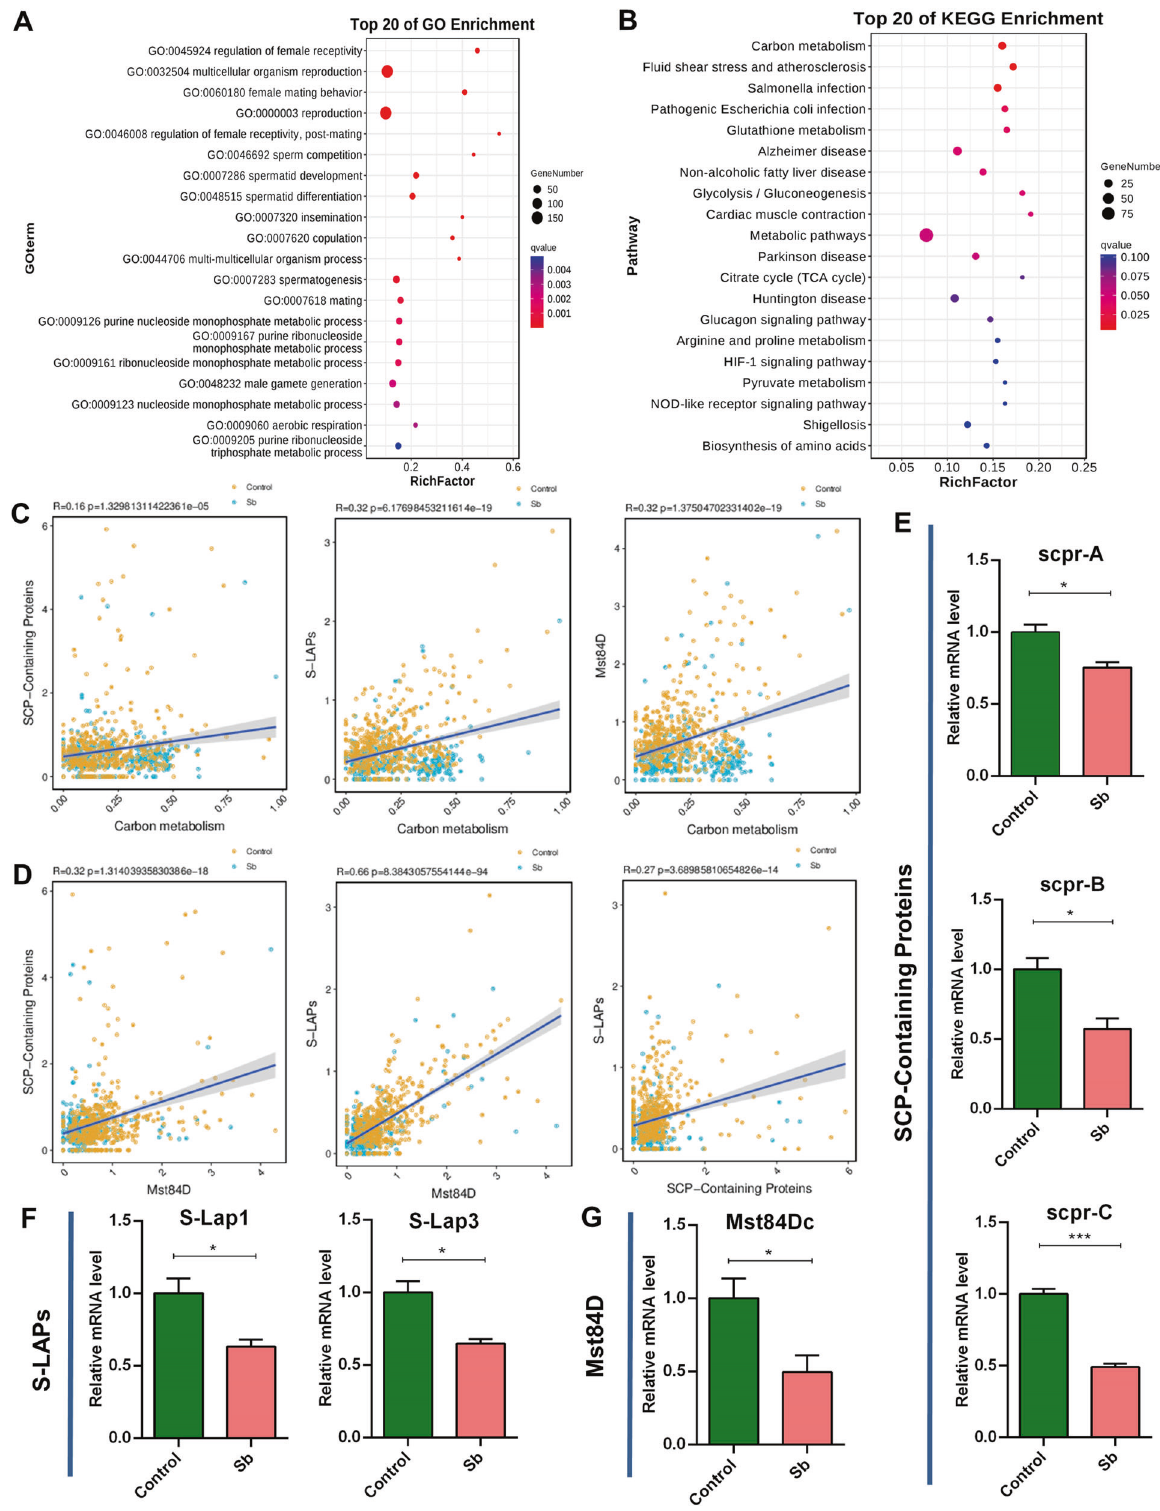
Fig. 4 Referred signatures for DEGs in mitotic germ cells. A Top 20 of GO enrichment for DEGs in GSCs_to_Early_Spermatogonia cell cluster. B Top 20 of KEGG enrichment for DEGs in GSCs_to_Early_Spermatogonia cell cluster. C Correlation analysis of carbon metabolism with SCP- Containing Proteins, S-LAPs, and Mst84D signatures in GSCs_to_Early_Spermatogonia cluster, respectively. D Correlation analysis among SCP-Containing Proteins, S-LAPs, and Mst84D signatures in GSCs_to_Early_Spermatogonia cluster. E qRT-PCR analysis of representative DEGs for SCP-Containing Proteins signature in testes. F qRT-PCR analysis of representative DEGs for S-LAPs signature in testes. G qRT-PCR analysis of representative DEG for Mst84D signature in testes. * P < 0.05, *** P < 0.001.